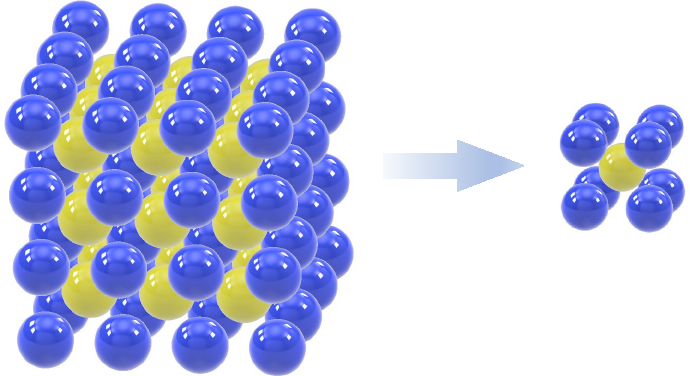
Figure 1. Extraction of a unit cell model from cyclic microstructures [14].